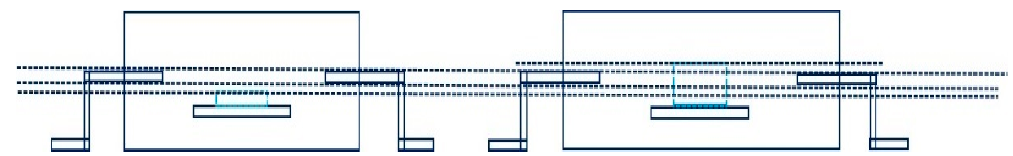
Figure 3. Schematic representation of a non-Manhattan transformation for a pLQFP, where the die (blue rectangle) thickness increases.